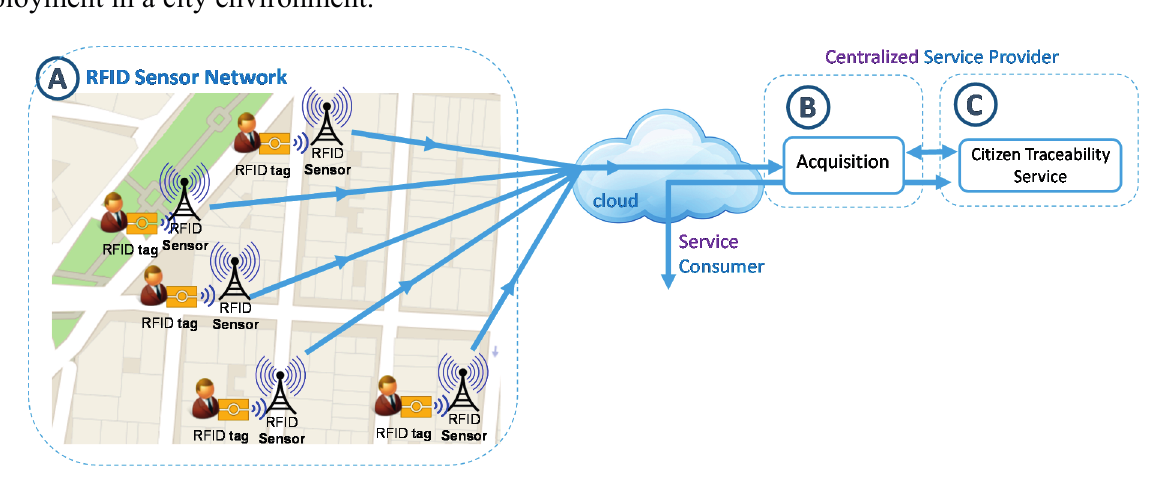
Figure 4. RFID sensor network deployment.